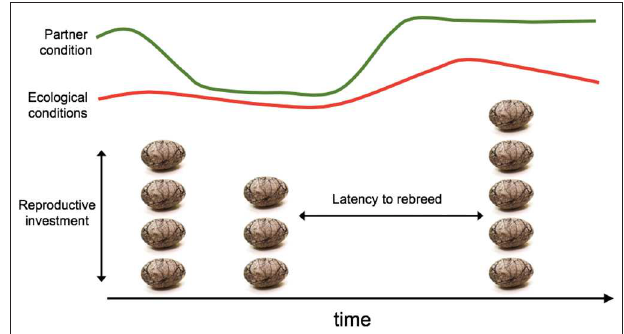
FIGURE 3 | In a species in which a pair breed together repeatedly in an ecologically variable context (red line), and in which individual condition varies over time (green line) there are complex decisions to make about the level of investment to make into different breeding attempts (egg number), and the timing of each clutch. Pairs that can optimize these decisions will produce the greatest number of offspring